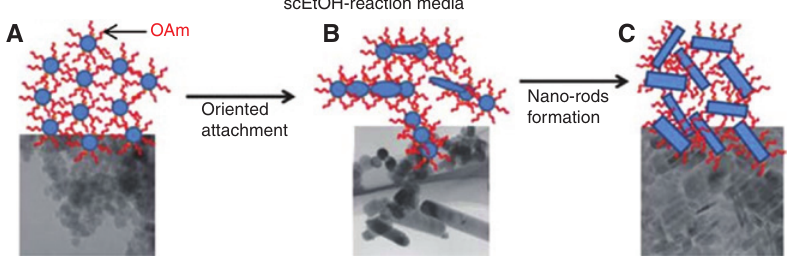
NPs obtained from supercritical ethanol/oleylamine 4